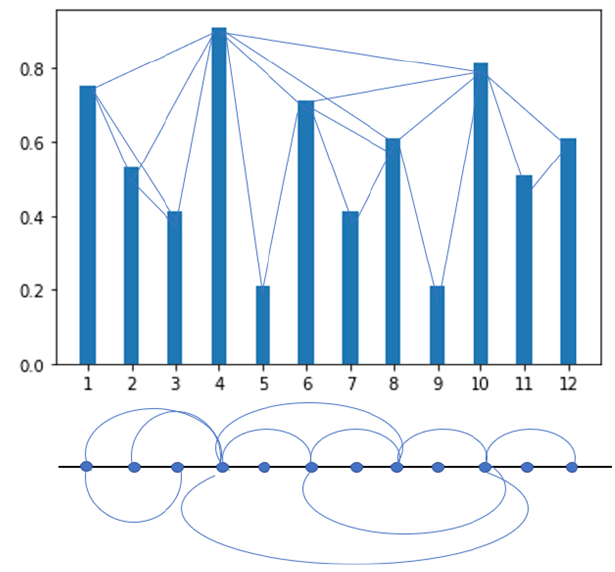
Figure 5. Example of a graph associated with a time series.